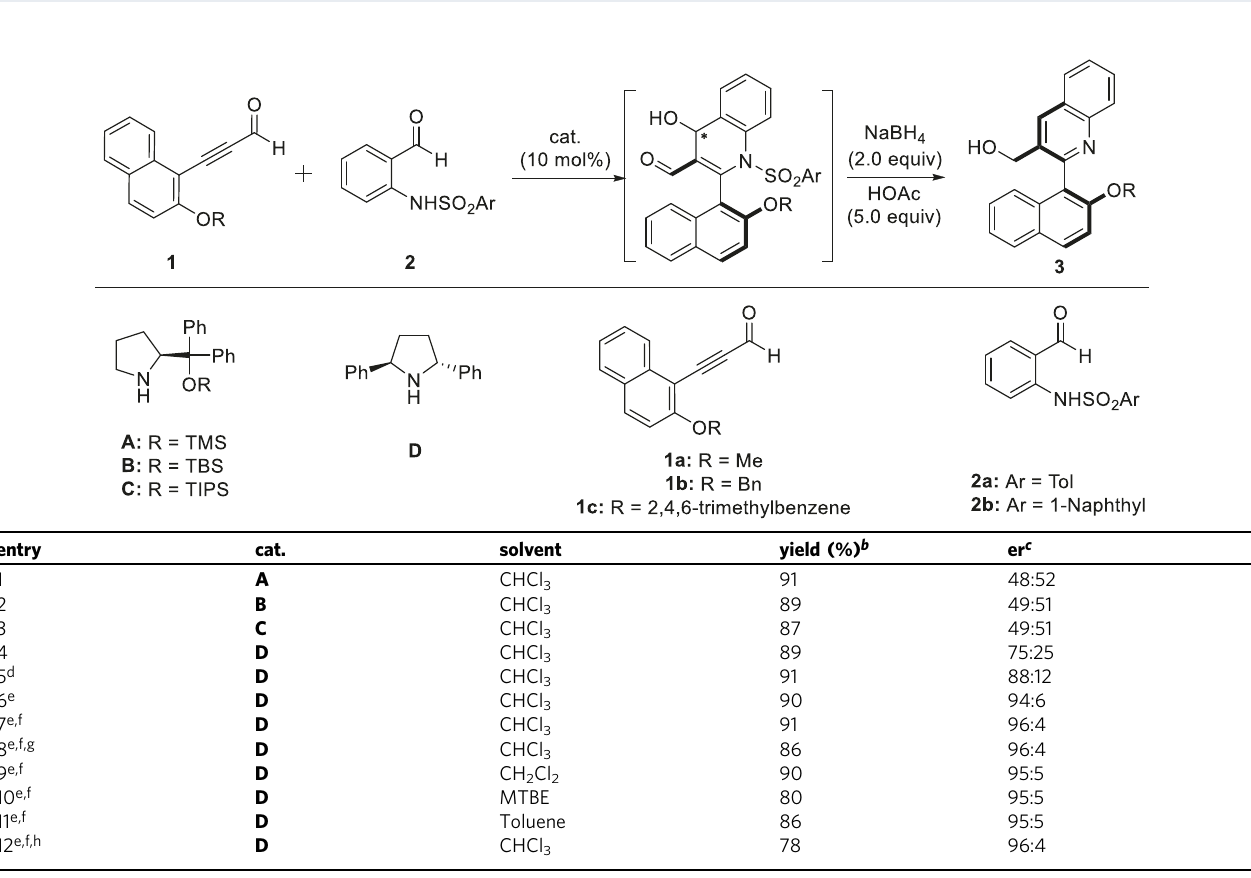
Table 1 Optimization of the reaction conditions a